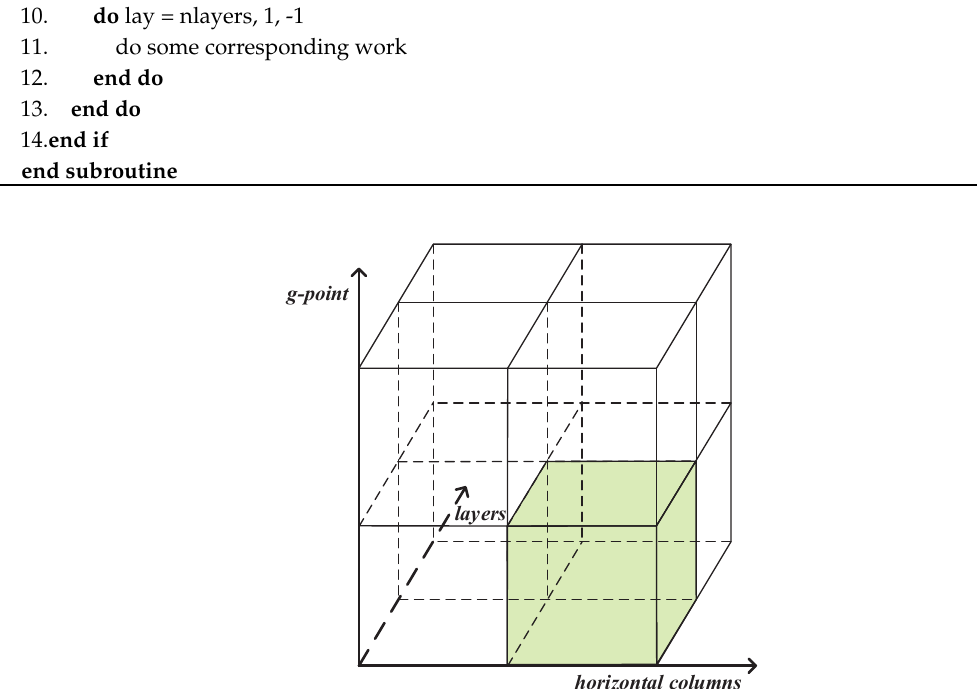
Figure 4. Schematic diagram of the decomposition in the g - point dimension for the RRTMG_LW in the GPU